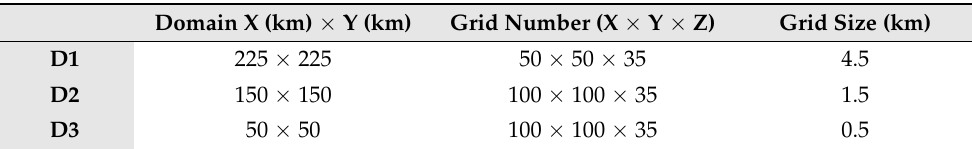
Table 1. Computational domains and grid arrangements [56].